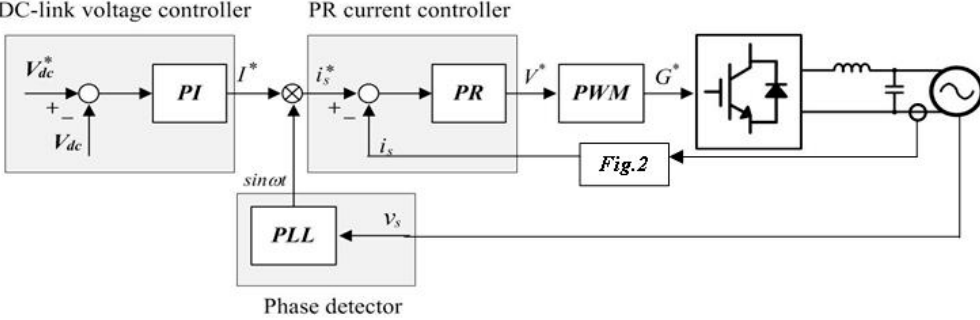
Figure 1. A proportional-resonant (PR) current control-based system block diagram of a single-phase grid-tied inverter.